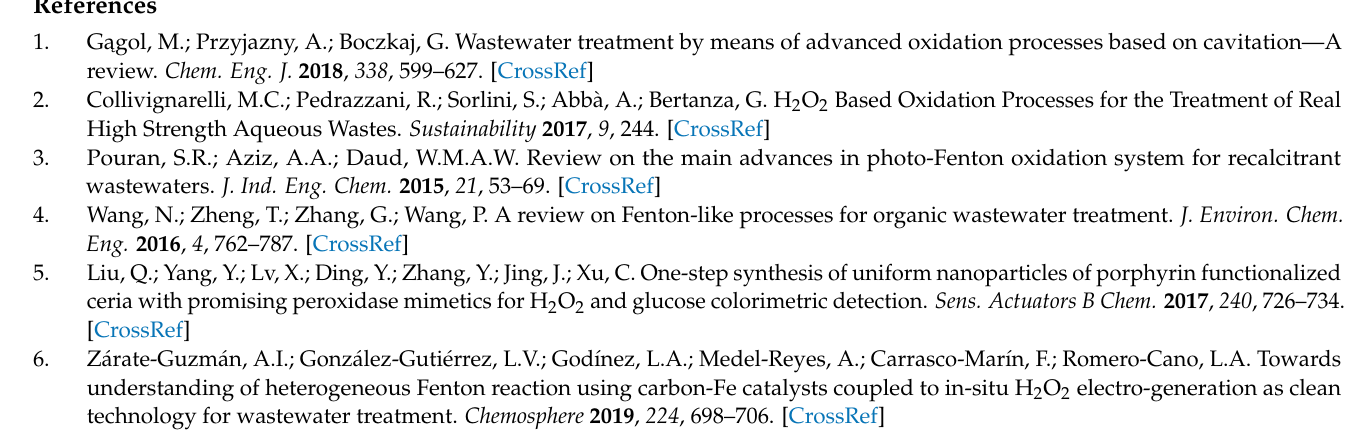
curves, Figure S2: α -Fe 2 O 3 (104) facet in the HRTEM image, Figure S3: Degradation of TC by different catalysts, Figure S4: XRD of fresh catalyst and after the fourth reused catalyst, Figure S5: The comparison of Pd 3d XPS spectra of different samples, Figure S6: O 2 -TPD curves of different catalysts, Table S1: Elements contents of FeNi-Pd@CN calculated from the EDS